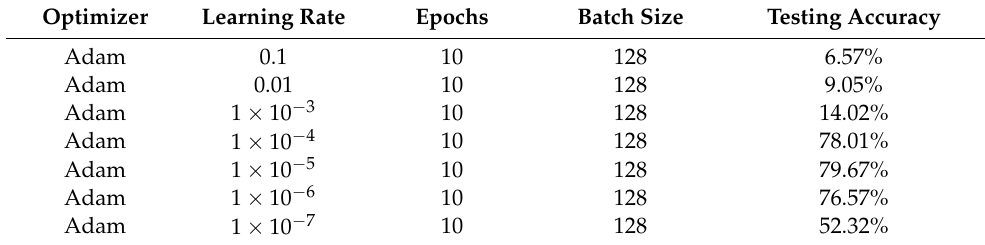
Table 4. Model results obtained during the fine-tuning process. All the models use the transformers- based architecture. The hyperparameters that are not listed in this table use the same settings presented in Table 3